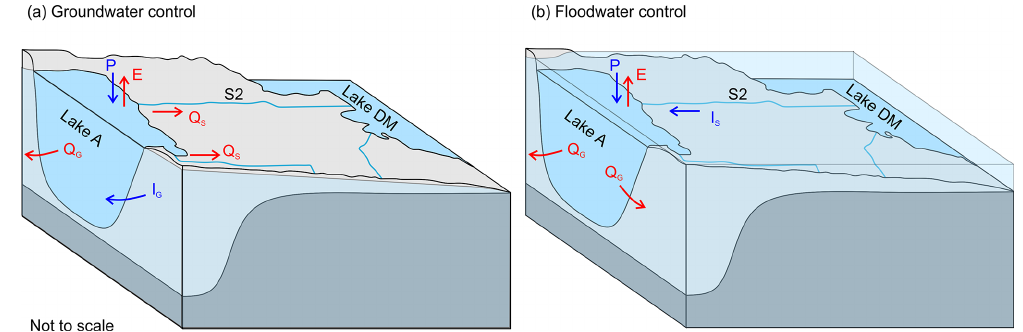
Figure 3. Schematic representation of the hydrological processes at lake A during (a) groundwater control and (b) floodwater control periods. Inputs include precipitation ( P ), surface water ( I S ), and groundwater ( I G ), while outputs include evaporation ( E ), surface water outflow ( Q S ), and groundwater outflow ( Q G ). The area between lake DM and lake A is flooded in (b) , and I S from lake DM contribute to the water balance of lake